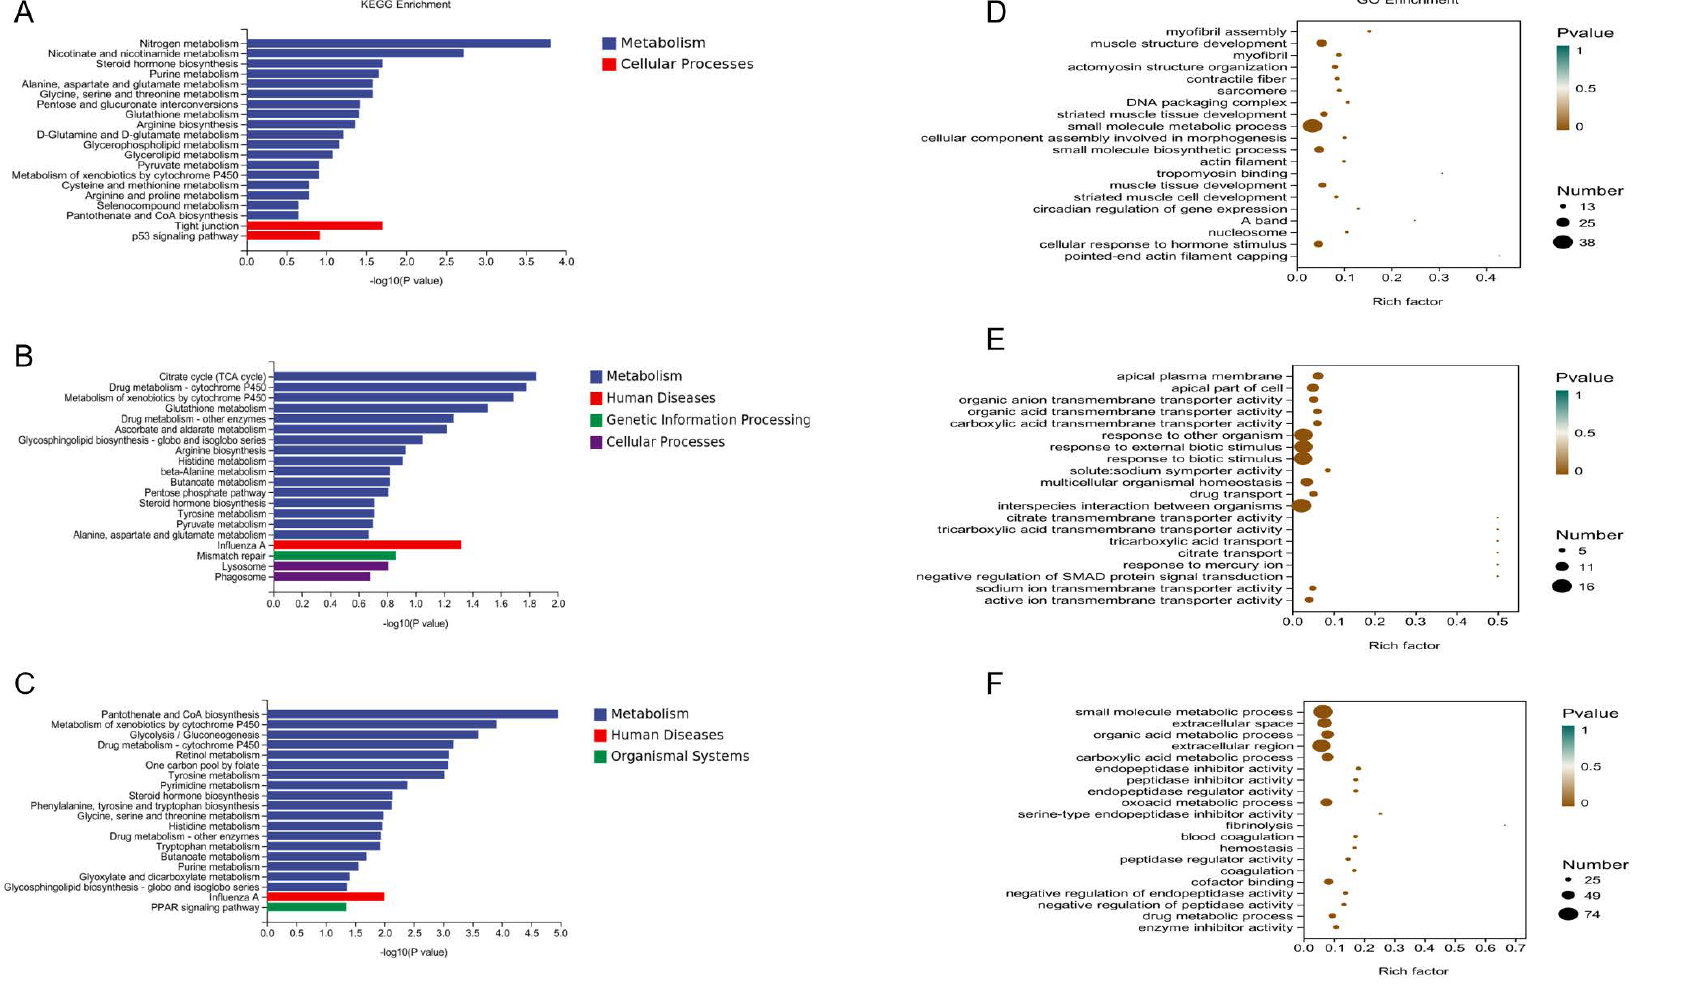
Figure 2. Top 20 GO and KEGG enrichment of DEGs. KEGG pathway ( A – C ) and GO term ( D – F ) enrichment were conducted with DEGs of three groups (caged vs. free-range, flat-net vs. caged, and flat-net vs. free-range). The vertical ordinate is the pathway name and the horizontal coordinate value is the ratio of enriched genes to total genes. The sizes of the point indicate how many DEGs are in the pathway, and the colors of different points correspond to different p -value